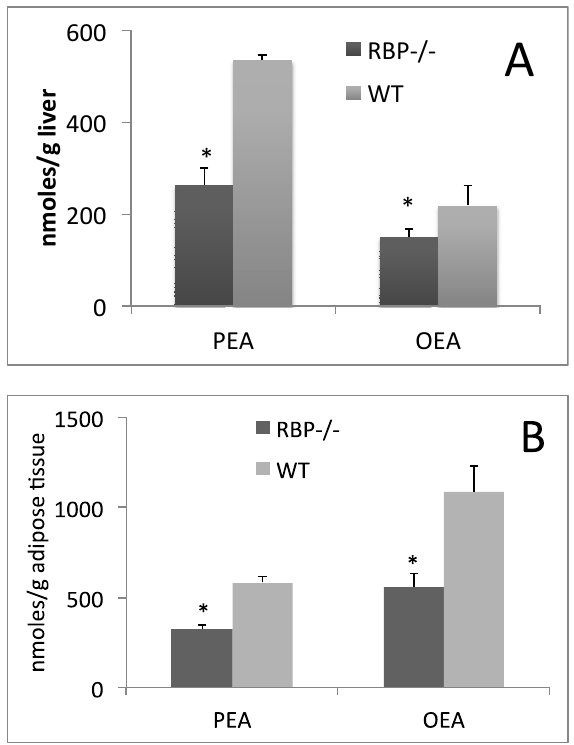
Figure 1. Palmitoylethanolamide (PEA) and oleoylethanolamide (OEA) levels in liver ( A ) and adipose tissue ( B ) of RBP − / − or wild type mice. * significant difference ( p < 0.05) with t -student